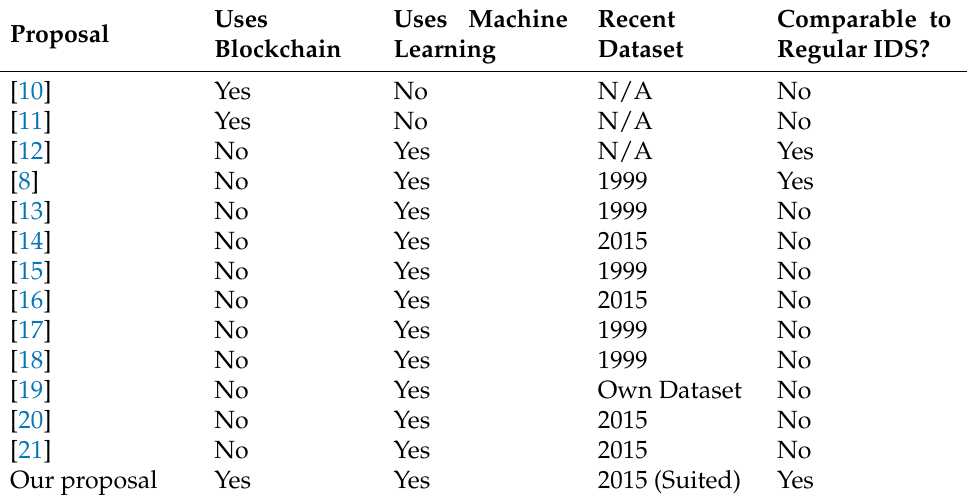
Table 1. Related